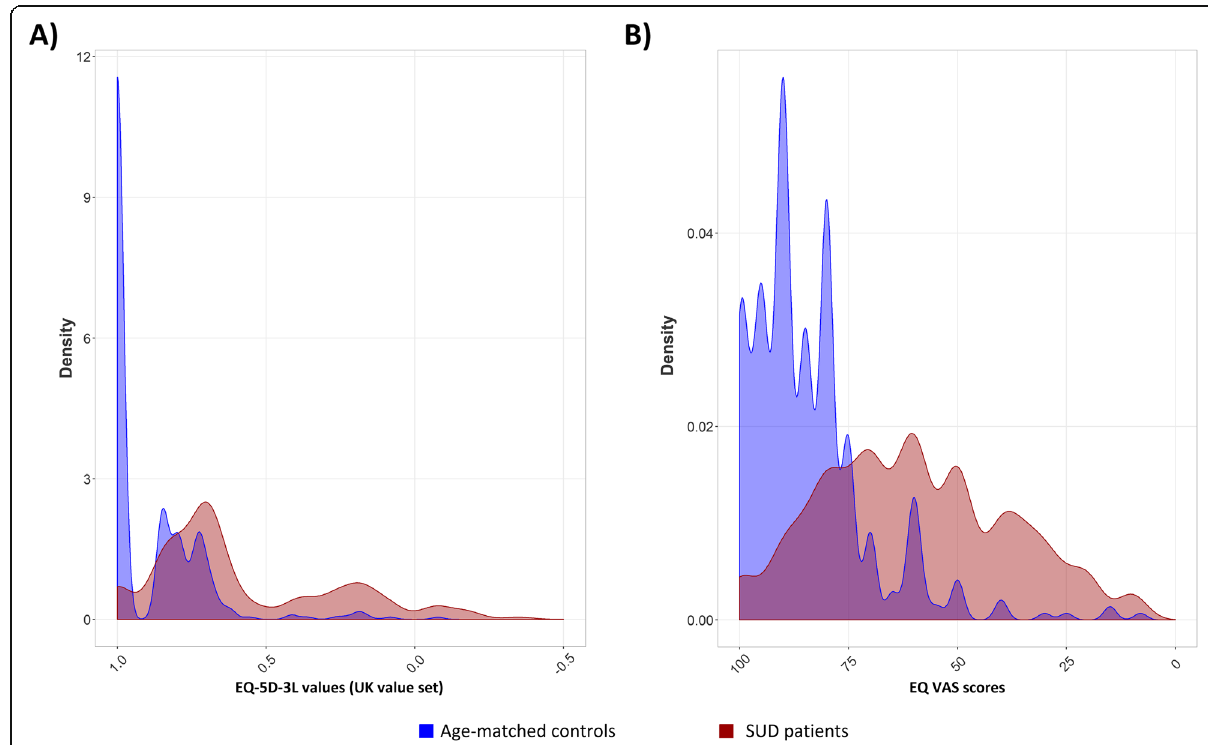
Fig. 1 Density plots for SUD patients (red) and general population respondents (blue), separately for ( a ) EQ-5D-3L index scores, and ( b ) EQ VAS